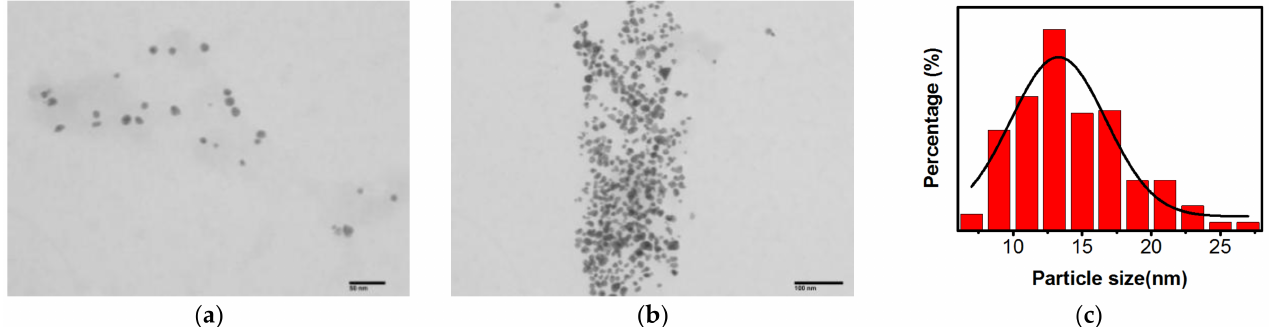
Figure 3. TEM images of AuNPs@Chlorella with different magnifications ( a ) (Scale bar: 50 nm) and ( b ) (Scale bar: 100 nm). ( c ) The particle size distribution of